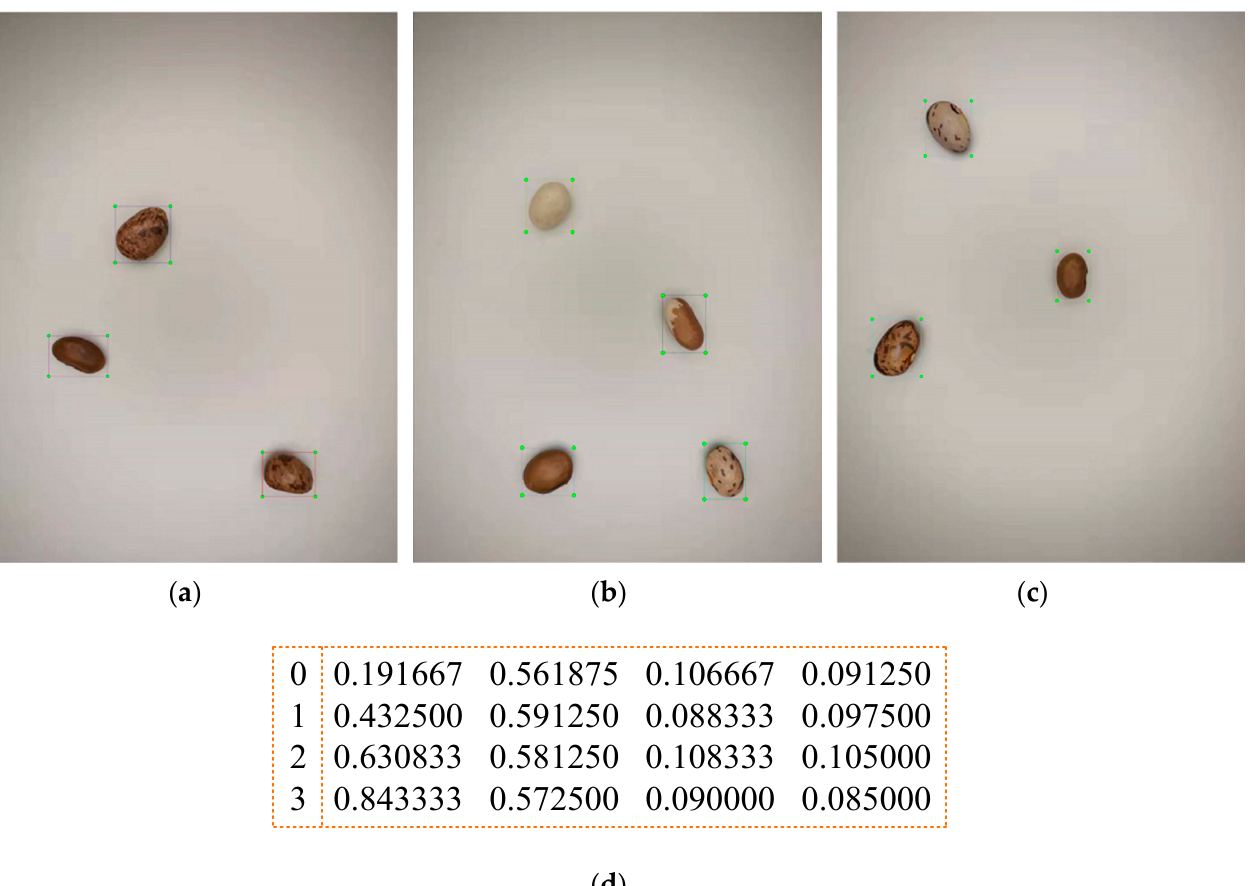
Figure 3. Labeling diagram of seeds: ( a – c ) The results of ten types of seed labeling; ( d ) The ID and coordinate location information of kidney bean seeds in ( b